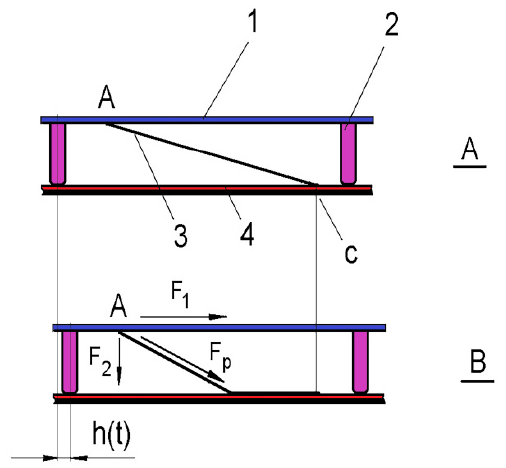
Figure 1. Schematic representation of the principle of electromechanical energy conversion under electrostatic rolling of a free metal film. 1—MP; 2—guides; 3—free metal film (movable electrode, ME); 4—FP. ( A )—the initial state of ME; ( B )—the position of MP and form of ME under action of voltage pulse. c is the place of pressing the ME to the surface of the ferroelectric. F p is thrust force, F 1 and F 2 —its tangential and normal components.